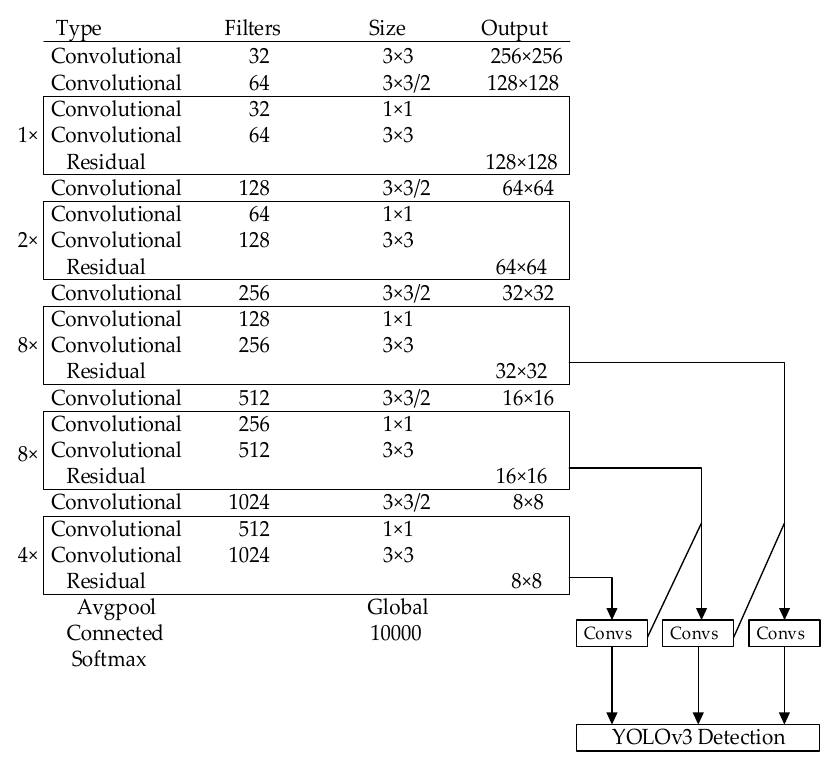
Figure 2. YOLOv3 network structure.